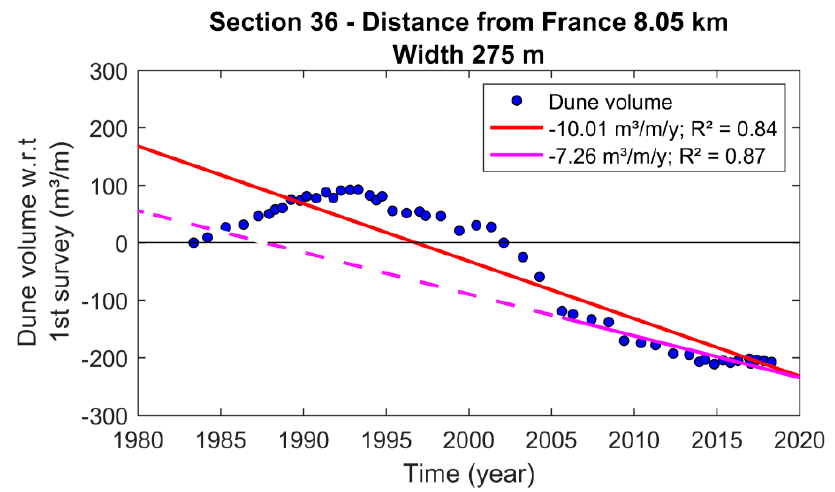
Figure 14. Decadal dune evolution of the coastal dunes at section 36. The solid magenta line indicates the recent dune trend.